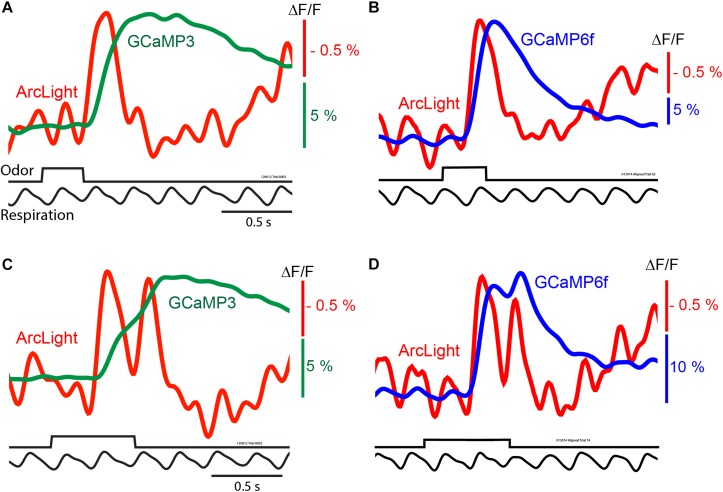
In vivo measurements of odorant responses in the mouse olfactory bulb using the GEVI ArcLight and two GCaMPs. Left panels (A,C) comparing ArcLight and GCaMP3 signals from opposite olfactory bulbs in the same preparation in response to odorant presentations lasting one and two breaths. Right panels (B,D) comparing ArcLight and GCaMP6f in response to odorant presentations lasting one and two breaths. The ArcLight signals are substantially faster than those of the GCaMPs. Modified from Storace et al. (2015).